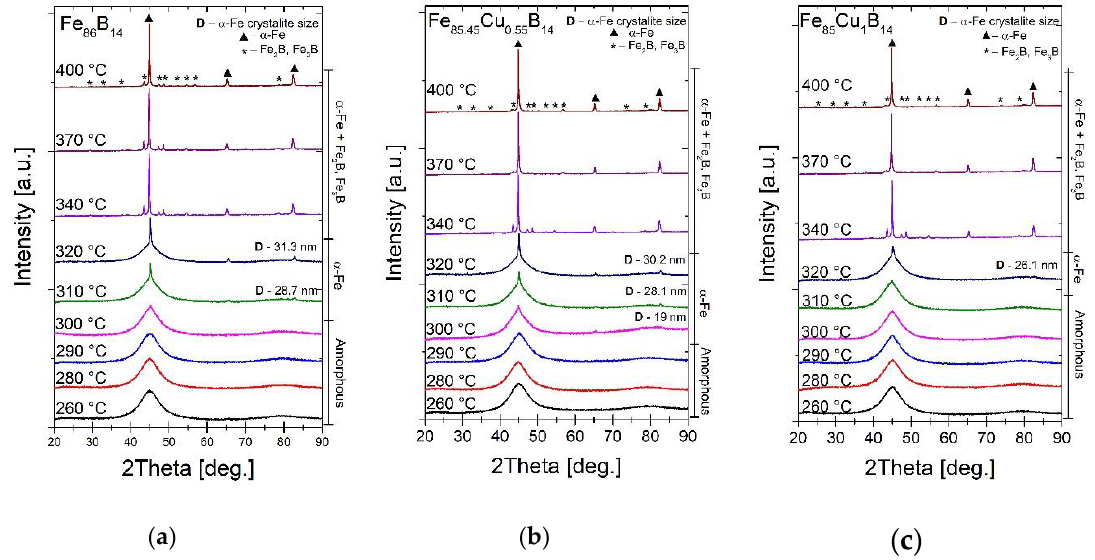
Figure 7. XRD patterns for annealed alloys: Fe 86 B 14 ( a ), Fe 85.45 Cu 0.55 B 14 ( b ), Fe 85 Cu 1 B 14 ( c ).